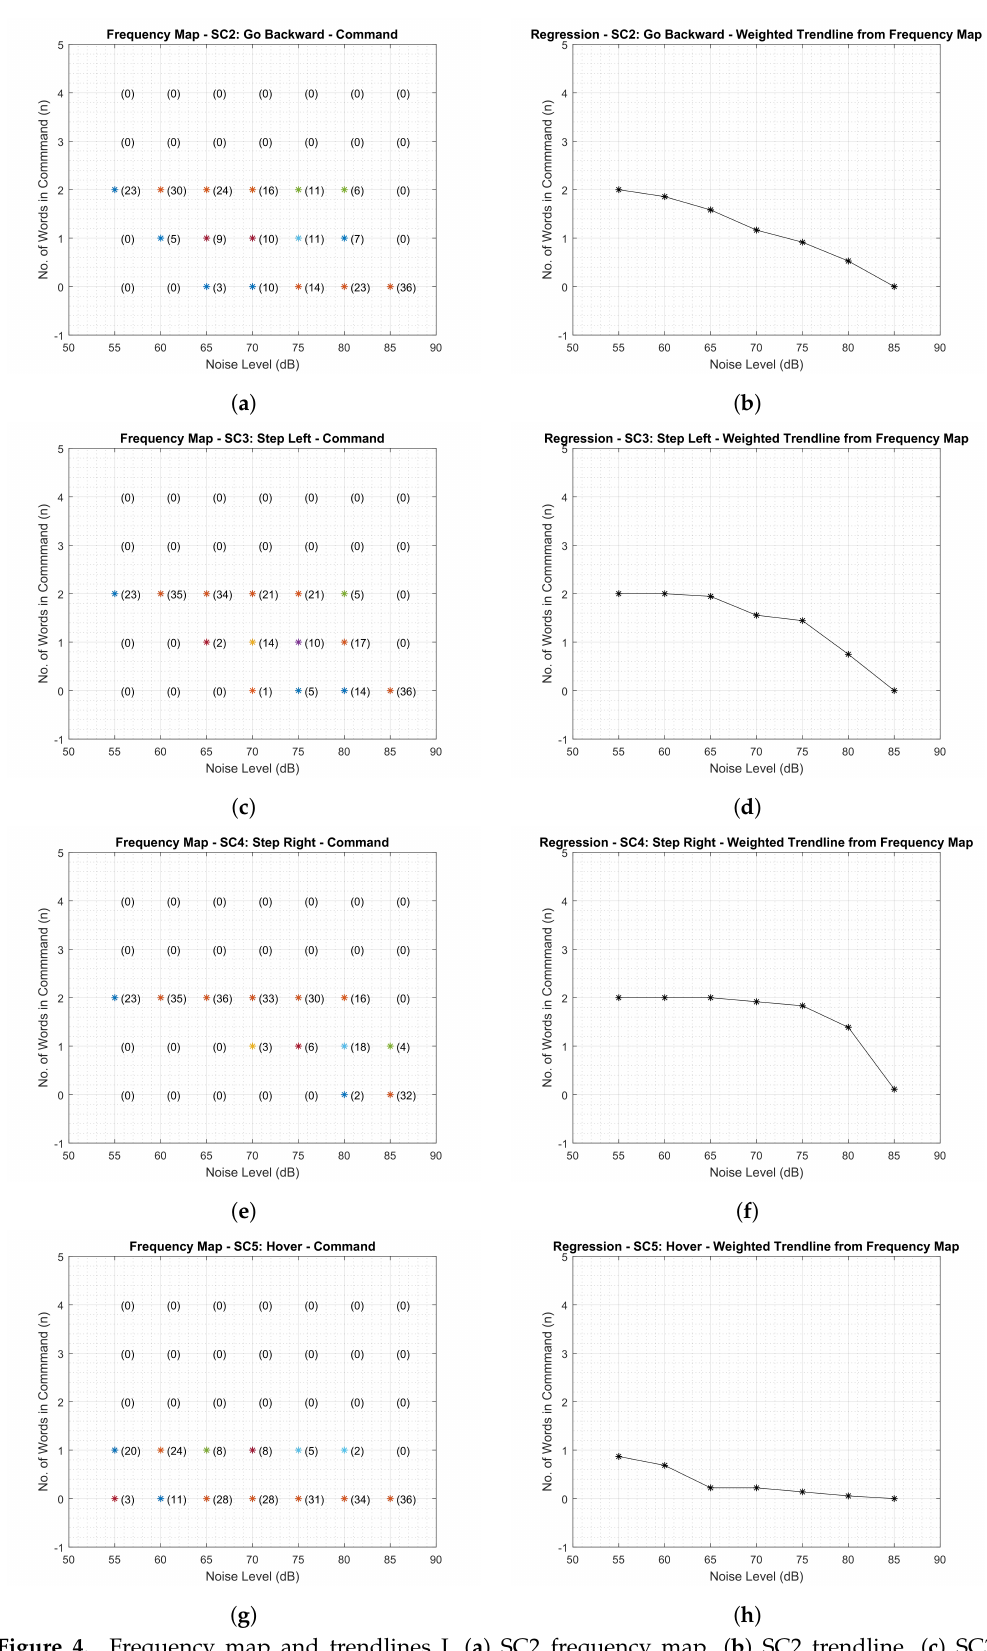
Figure 4. Frequency map and trendlines I. ( a ) SC2 frequency map, ( b ) SC2 trendline, ( c ) SC3 frequency map, ( d ) SC3 trendline, ( e ) SC4 frequency map, ( f ) SC4 trendline, ( g ) SC5 frequency map, ( h ) SC5